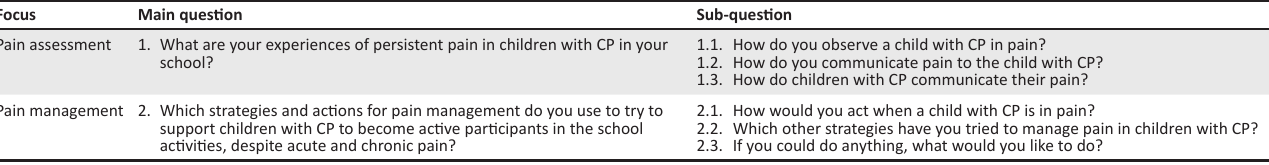
TABLE 4: Questions and supporting sub-questions used during focus group